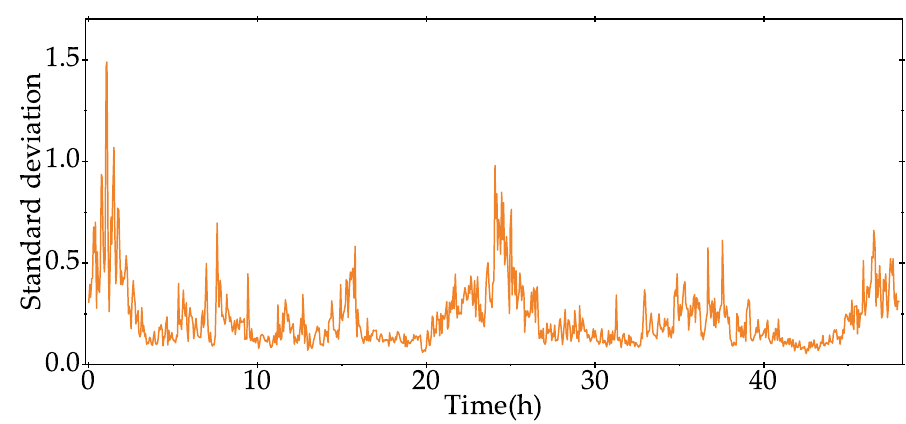
Figure 4. Cumulative phase (CP) curves of the RPS points.